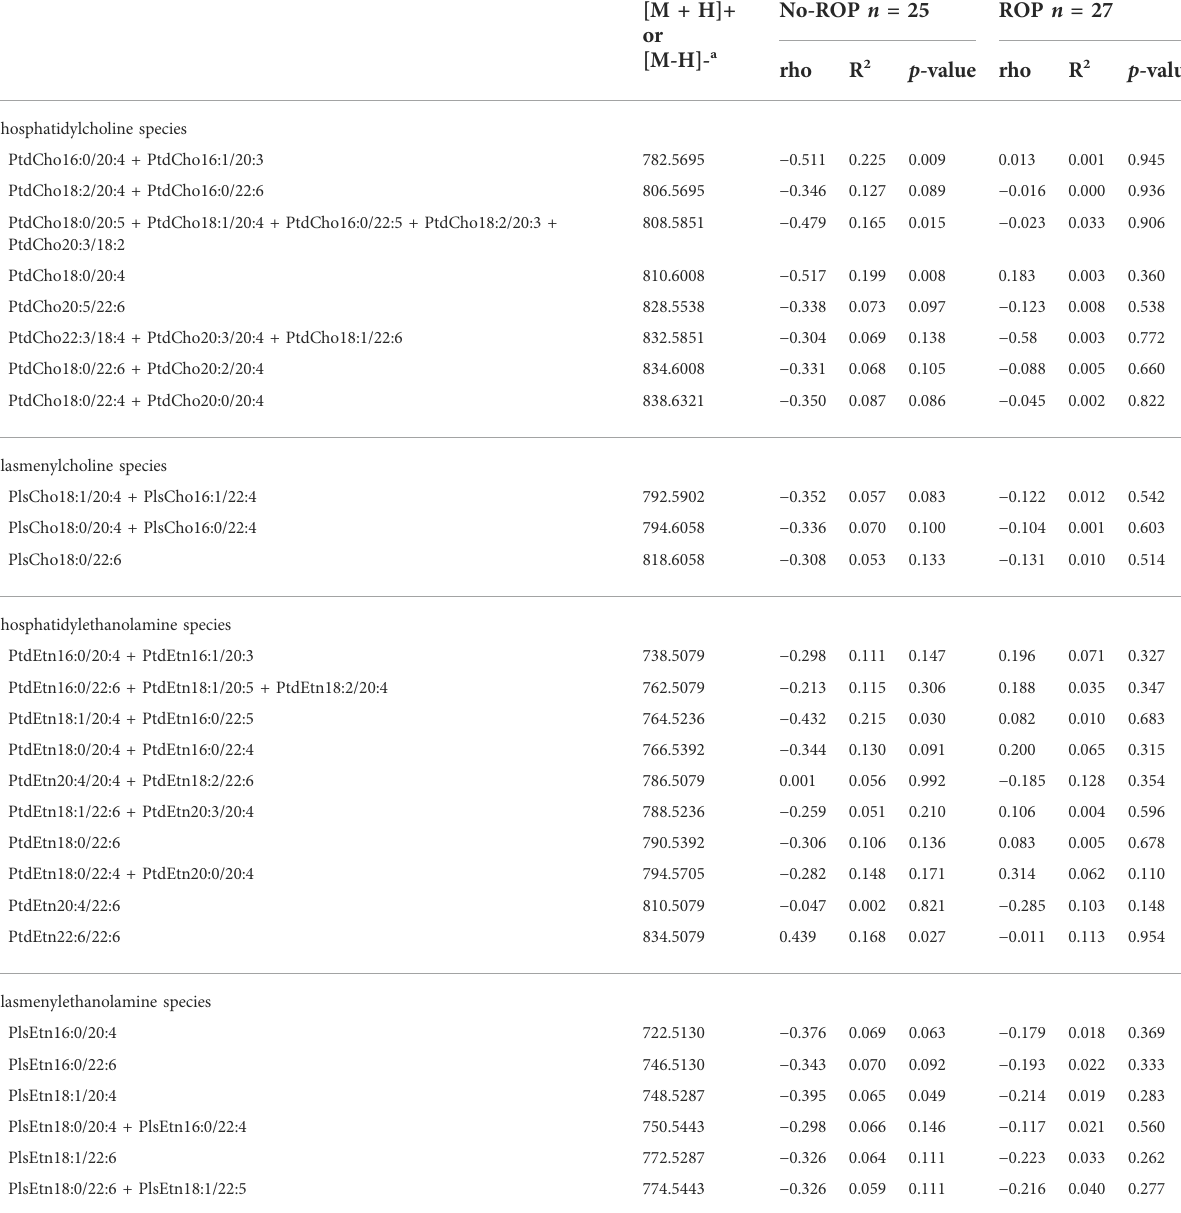
TABLE 3 Spearman correlations between gestational age and erythrocyte individual phospholipids species esteri fi ed with n-6 and/or n-3 PUFAs in preterm infants with or without retinopathy of